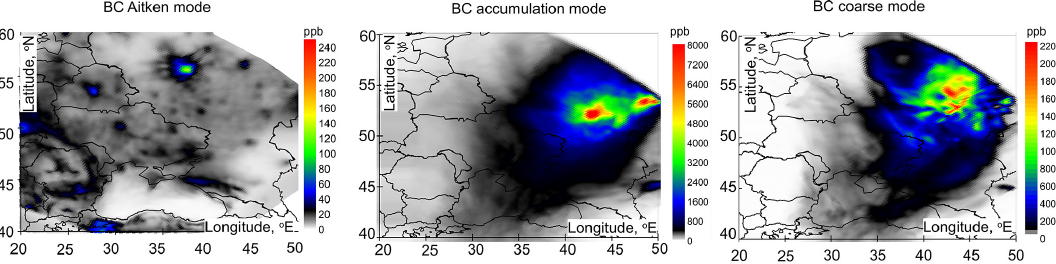
Figure 3. The integral value of the near-surface BC concentrations for the Aitken, accumulation, and coarse modes for the period 3– 18 August 2010.